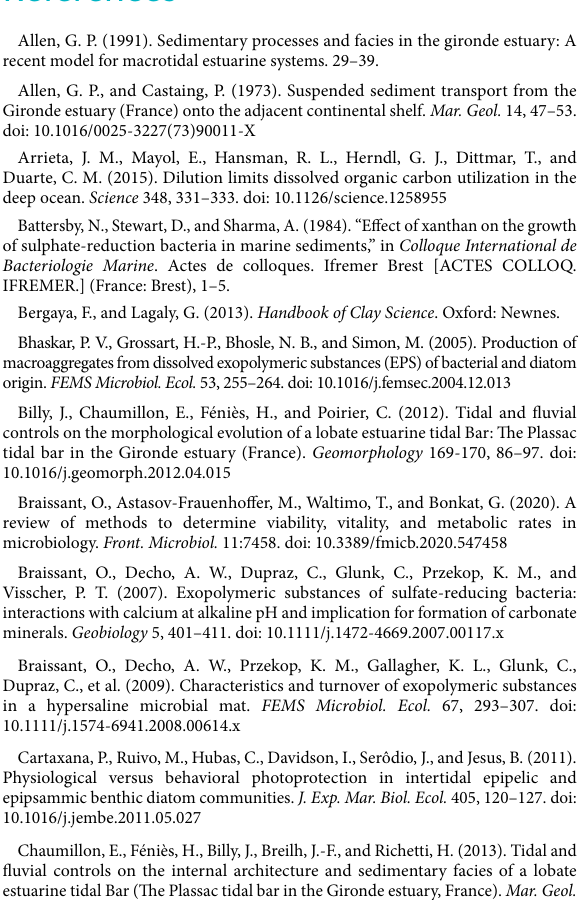
SUPPLEMENTARY FIGURE S8 FTIR spectra of four exopolymeric substances samples recovered from different depths along the BXN Long Core (3.68, 4.12, 5.20, 5.64m depth). Colored lines highlight the EPS absorption bands, while black dotted lines indicate clay mineral absorption bands.